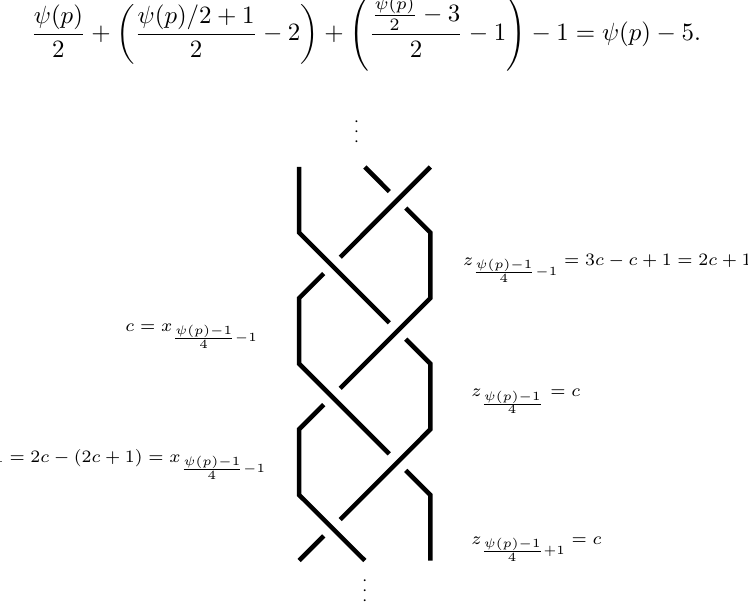
, z ψ ( p ) for prime p with ψ ( p ) even and 4 (cid:45) ψ ( p ) 2 +1 2 +1+1